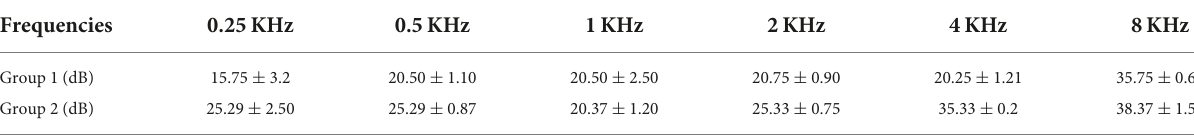
TABLE 7 The average postoperative differences in A-B gap of patients with type II labyrinthine fistulas in group 1 and group 2. Frequencies